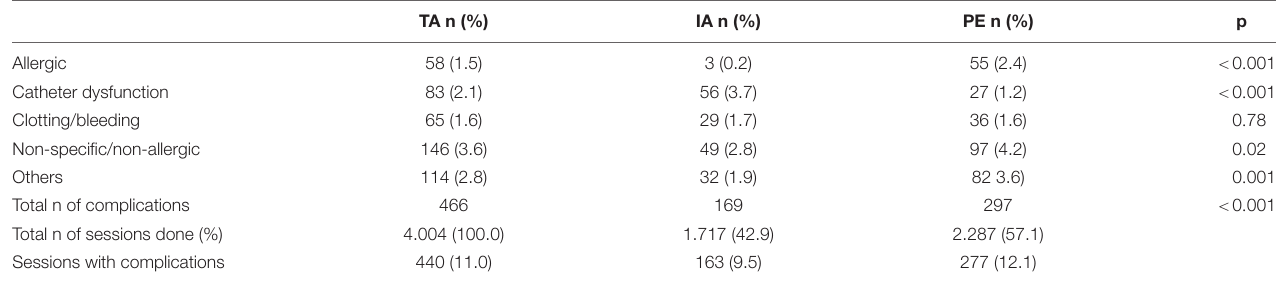
TABLE 4 | Complications according to treatment